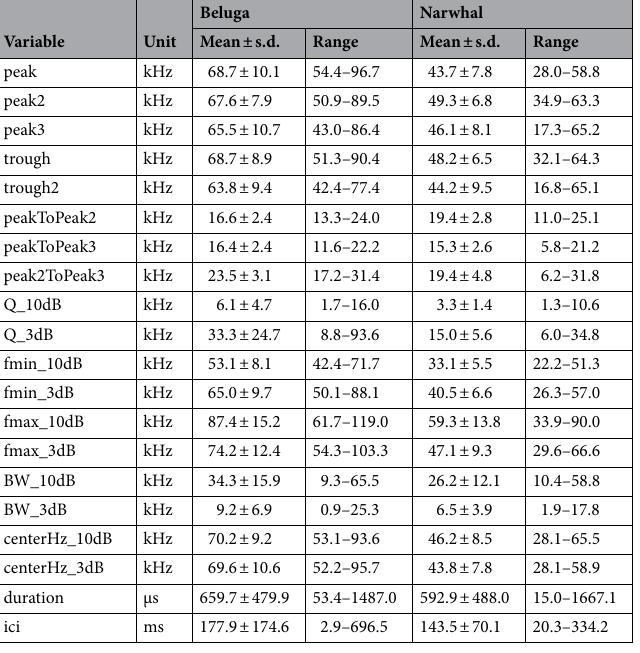
Table 2. Summary of signal parameter measurements for beluga and narwhal echolocation for all 81 acoustic events (beluga: n = 19; narwhal: n = 62). Mean ± standard deviation (s.d.) and range (min–max) are provided.